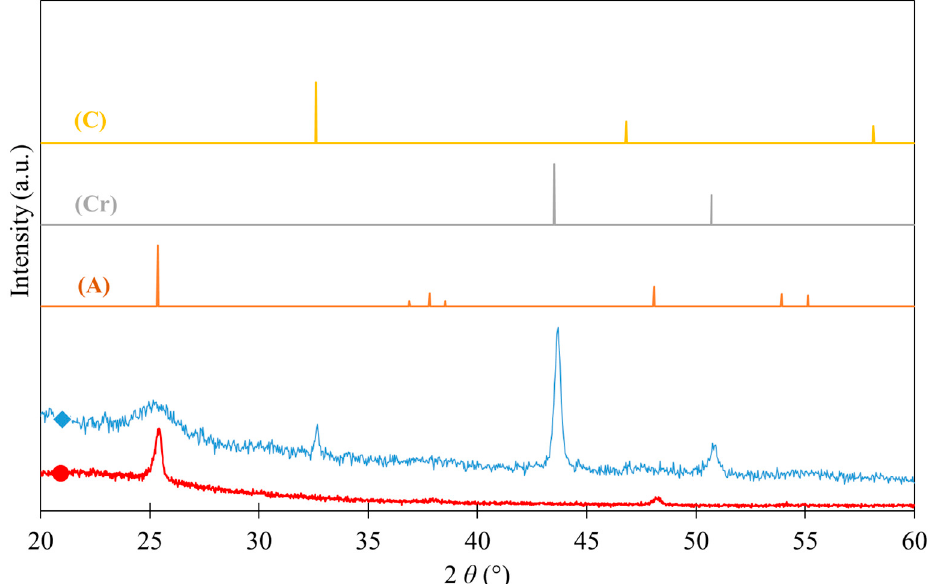
Figure 7. Grazing incidence X-ray diffraction (GIXRD) pattern of ( ♦ ) a TiO 2 /Fe0.25/N43 film on steel, ( • ) a calcined TiO 2 film on glass, (A) reference pattern of anatase, (Cr) reference pattern of chromium, and (C) reference pattern of chromium oxide.